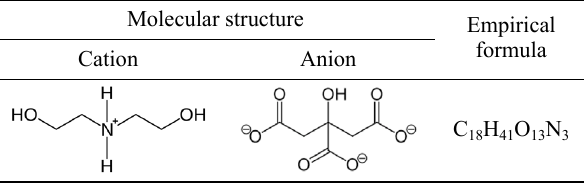
Table 2 Molecular structure and empirical formula of